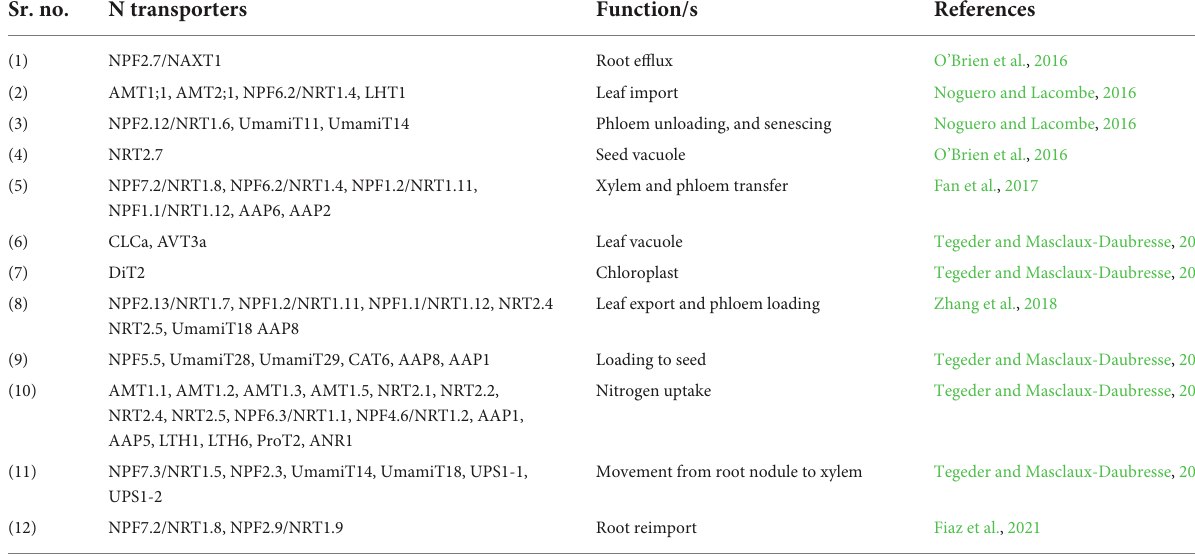
TABLE 1 Various nitrogen transporters involved in different functions of nitrate uptake, utilization, and remobilization. Sr.